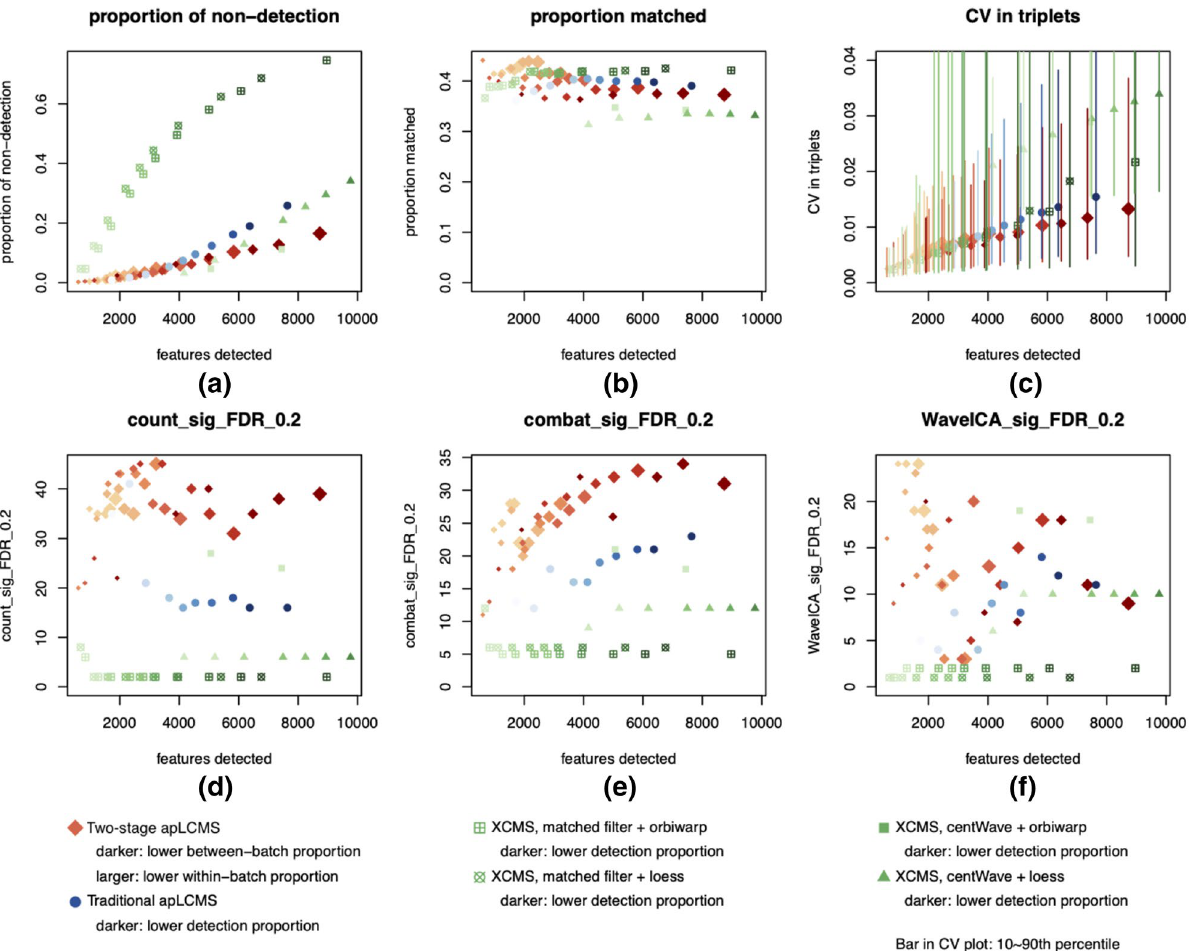
Figure 4. Comparison of the two-stage approach with traditional apLCMS and XCMS using CHDWB samples. Each dot represents a parameter setting. ( a ) Proportion of zeros in the final data matrix before merging triplets for each subject; ( b ) proportion of features with m/z matched to known metabolites by xMSAnnotator; ( c ) average within-triplet coefficient of variation (CV). Point is median; vertical bars represent 10th–90th percentile. ( d ) Number of significant features at FDR ≤ 0.2, without batch effect correction; ( e ) Number of significant features at FDR ≤ 0.2, after batch effect correction by ComBat; ( f ) Number of significant features at FDR ≤ 0.2, after batch effect correction by